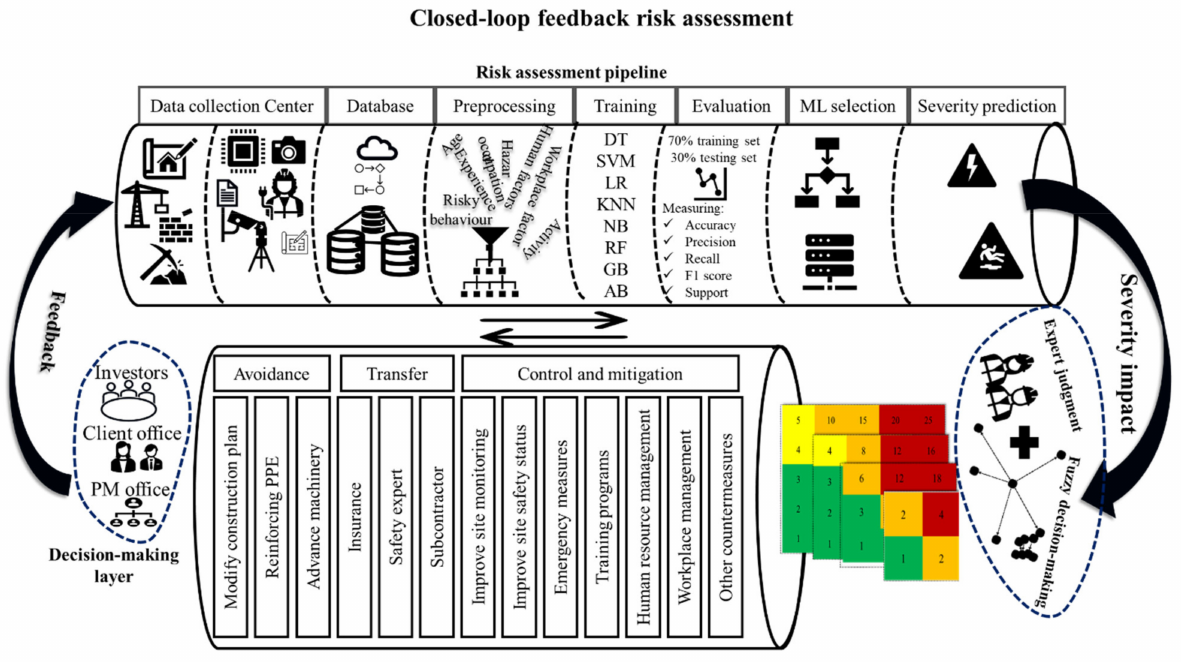
Figure 14. Developed automated ML system within a closed-loop feedback RA